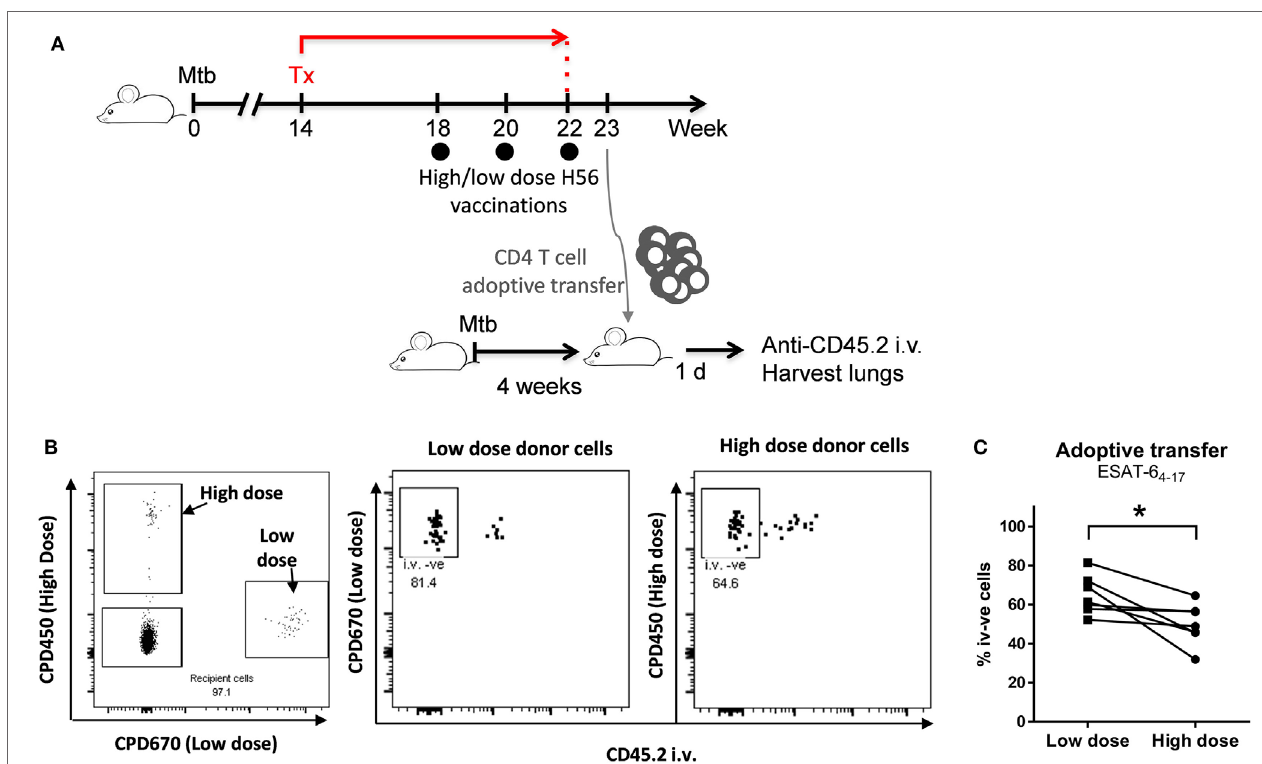
FigUre 5 | A high H56 dose given post-exposure leads to reduced ability of vaccine-specific CD4 T cells to home into the parenchyma. C57BL/6 mice were vaccinated post-exposure three times with a high (50 µg) or lower (5 µg) dose of H56 in CAF01 in a slightly modified post-exposure model as outlined in (a) . Spleen- and dLN-derived CD4 T cells were isolated 5 days after last vaccination. CD4 T cells from high dose vaccinated animals were then stained with Cell Proliferation Dye 450 (CPD450), and cells from low dose vaccinated animals stained with CPD670. Pooled CD4 cells from high and low dose vaccinated animals ( n = 7) were then combined in a 1:1 ratio and adoptively transferred into seven C57BL/6 mice infected 4 weeks earlier with Mycobacterium tuberculosis (Mtb) Erdman (10–50 CFU by the aerosol route). ~20 h after adoptive transfer, recipient mice were euthanized after an i.v. injection of anti-CD45 FITC. I-Ab-ESAT-6 4–17 tetramer enriched lung lymphocytes of recipient CD45 i.v.-stained mice were then analyzed for abundance and localization of donor cells. The CD45 i.v. stain allowed differentiation of vascular and parenchymal T cells: CD45 i.v.-positive cells derived from the lung vasculature, and CD45 i.v.-negative cells derived from the lung parenchyma (protected from the intravascular CD45 stain). (B) The left panel shows a representative dot plot gated on live, I-Ab-ESAT-6 4–17 + ve lung CD4 T cells (singlets > lymphocytes > live CD4 T cells > ESAT-6 Tet + ve). Double-negative cells, endogenous recipient ESAT-6-specific CD4 T cells. CPD450 + cells, ESAT-6-specific CD4 T cells (high dose vaccinated donors). CPD670 + cells, ESAT-6-specific CD4 T cells (low dose vaccinated donors). The right plots show representative CD45 i.v. stain of donor cells from low dose (mid panel) and high dose (right panel) vaccinated donors. Percentages represent CD45 i.v. negative cells, i.e., relative proportion of parenchymal CD4 T cells from each donor population. (c) Data points represent percentage CD45 i.v. negative (parenchymal) lung CD4 T cells derived from low dose (filled squares) and high dose (filled circles) vaccinated donors gated as shown in (B) . Lines represent matched pairs (donor cells transferred into the same recipient). Statistical analysis was performed by a paired Student’s t -test. * p < 0.05. This experiment was performed